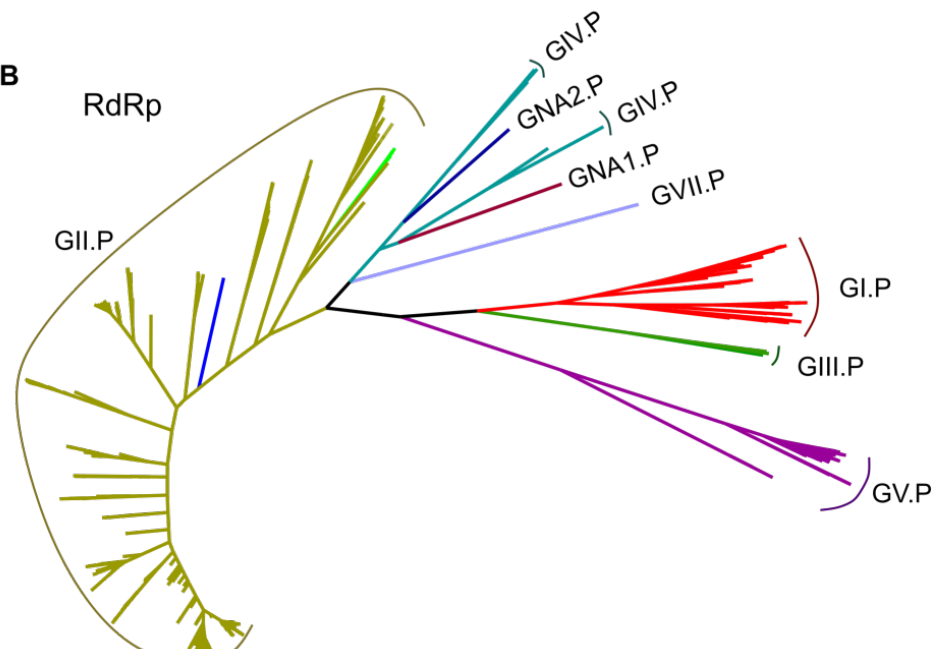
Figure 1. The maximum likelihood tree of the VP1 ( A ) and RdRp encoding ( B ) sequences (N = 1084) of the genus Norovirus . The tree branches are colored according to the capsid genogroup in both trees. The number of sequences in the dataset belonging to each capsid genogroup is indicated in brackets. In the phylogenetic tree for RdRp P-groups are shown. GII.P includes viruses with GII, GVIII and GIX capsid genogroups. The silhouettes of hosts infected by norovirus genogroups are shown near the tips.